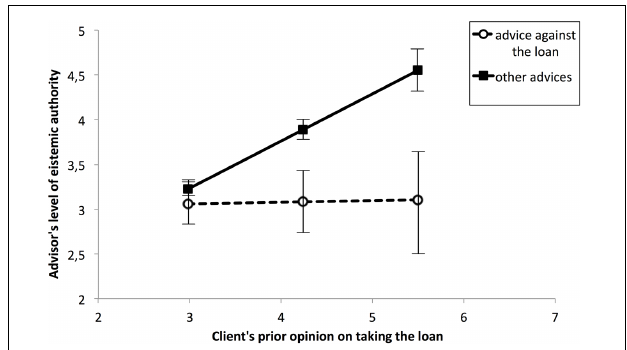
FIGURE 2 | Epistemic authority as a function of type of advice and perceptions of client’s prior opinion on